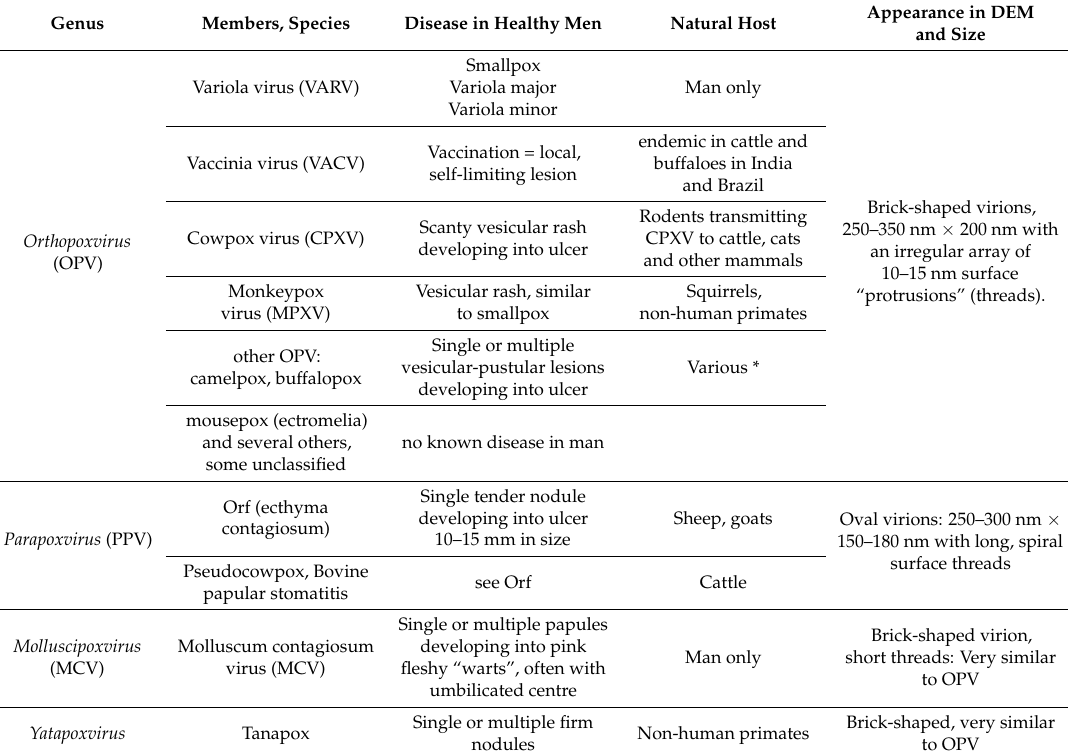
Table 2. The Poxviridae : Genera of the Chordopoxvirinae of Medical Interest